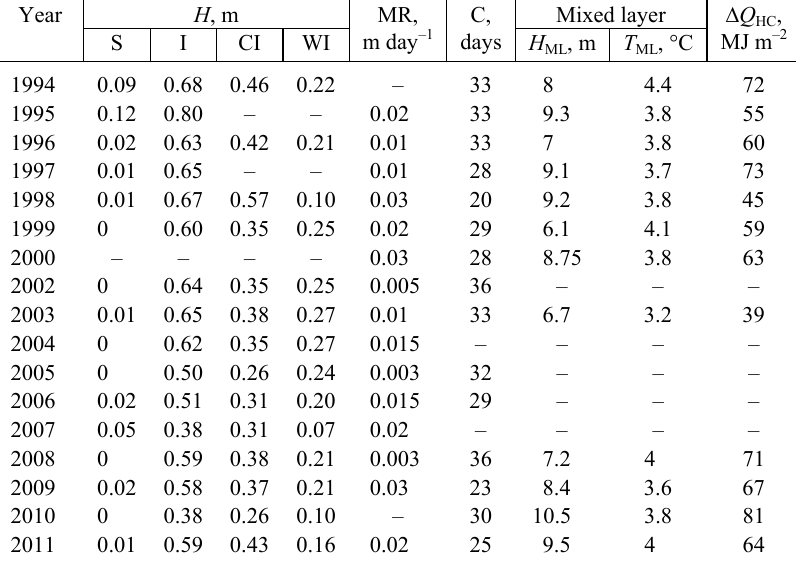
Table 2. The thickness of the snow (S ), total ice (I ), congelation ice (CI ), white ice (WI ) and the melting rate (MR) in mid-April in different years; the duration of convection (C ), the thickness ( H ML ) and the temperature ( T ML ) of the mixed layer, as well as an increase in the heat content of the water column during the period of convection ( ∆ Q HC ) H ,